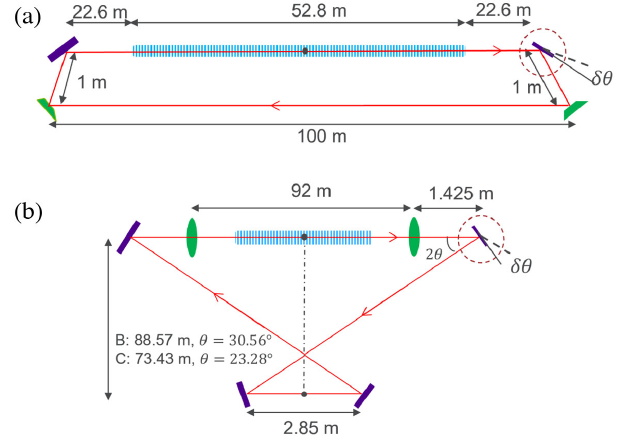
FIG. 4. XFELO cavity configurations based on (a) two focus- ing mirrors (green) and two flat crystals (purple) for XFELO-A, and (b) two compound refractive lenses (green) and four crystals (purple) forming a bow-tie pattern for XFELO-B (with θ ¼ 30 . 56 ° for C444 crystal) and XFELO-C (with θ ¼ 23 . 275 ° for C333 crystal). Figures are not drawn to scale. For (a), the geometrical shape is only approximate and determined by the choice of crystals and focusing